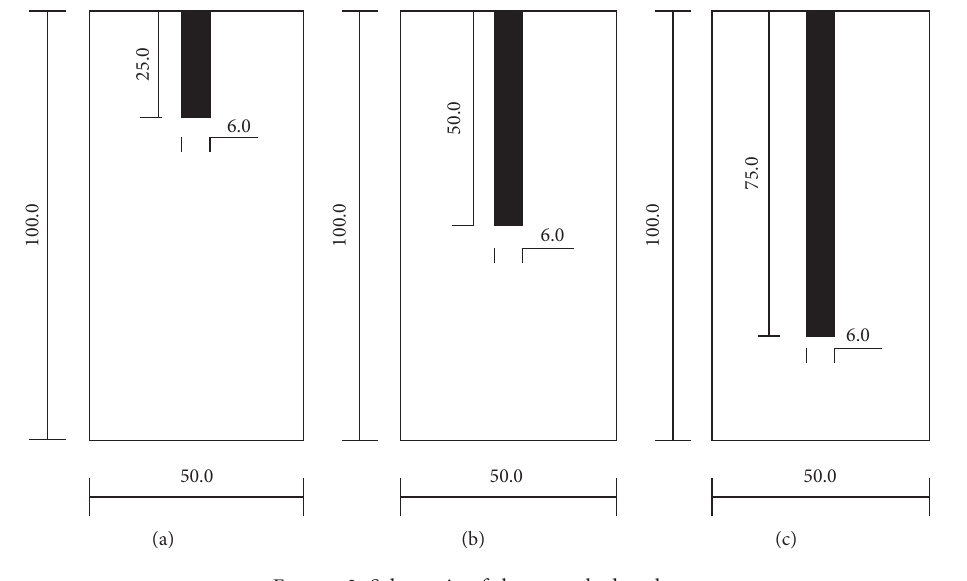
Figure 2: Schematic of three cracked